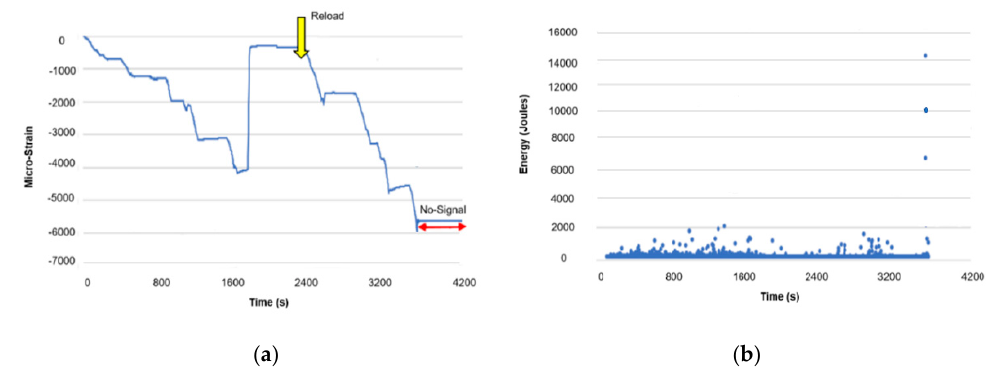
Figure 10. Micro-strain and AE energy over time in tension mode under single load test ( a ) micro-strain; ( b ) AE energy.